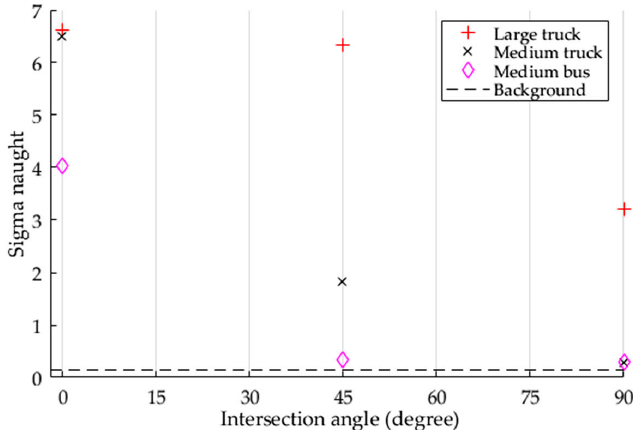
Figure 6. The sigma naught ( σ 0 ) of each vehicle at three intersection angles, as determined in Experiment I.